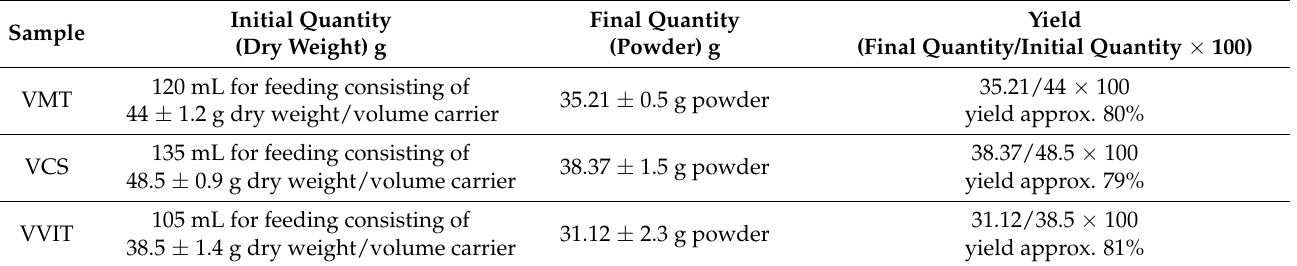
Table 1. Results obtained for plant-based powders.